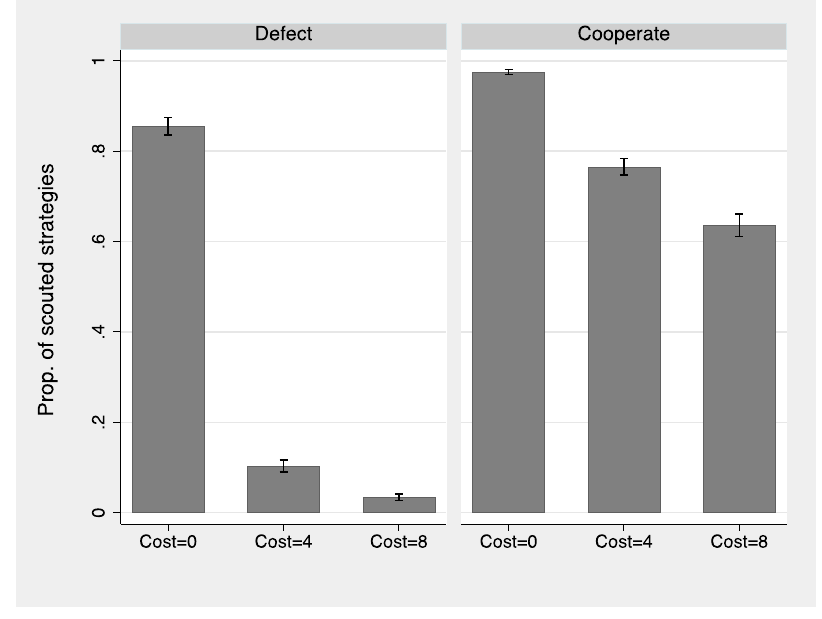
Figure 7. Fraction of scouted links among potential links by individual action and treatment (cost of information). ‘‘Scouting’’ means that the player asked to see the action of the potential neighbor. Both defectors and cooperators scout when information is freely available. Defectors almost cease to scout once information on the neighbor’s action becomes costly. Cooperators continue to scout as information becomes costly, albeit at a lower rate than in the free-information treatment. The capped spikes plot the standard errors of the mean.